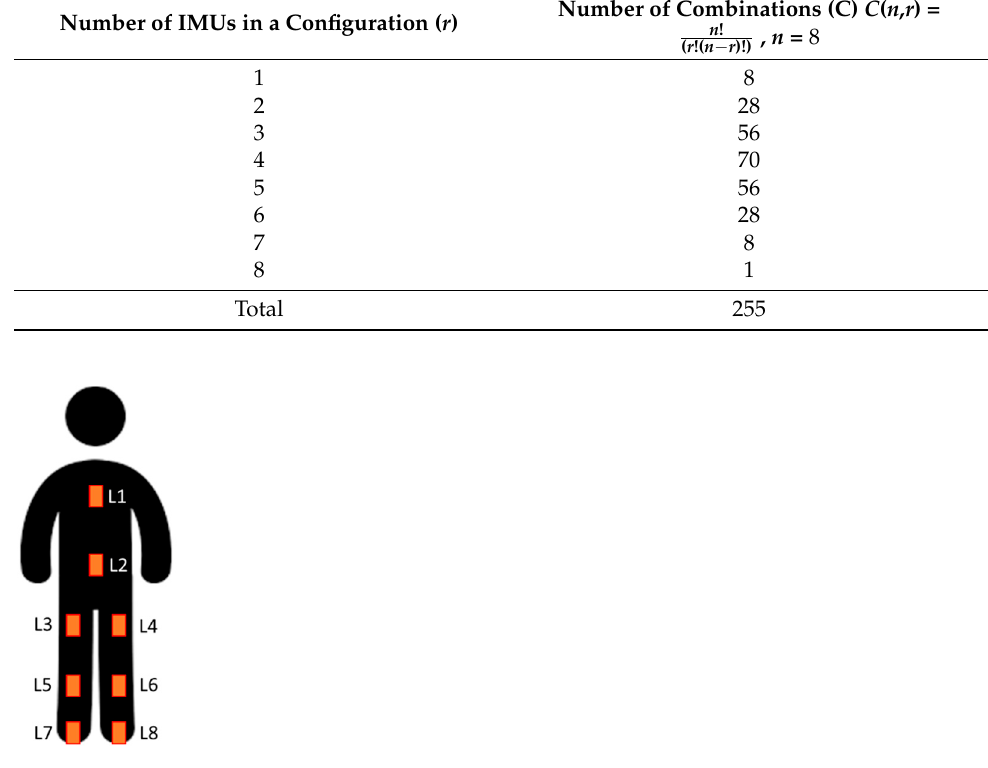
Figure 4. IMU location codes: L1 , sternum; L2 , pelvis; L3 , right thigh; L4 , left thigh; L5 , right tibia; L6 , left tibia; L7 , right foot; L8 , left foot. Table 4. Selected sensor combinations and number of lower limb joints per